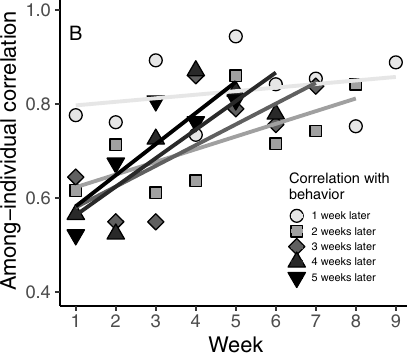
among-individual correlation between behavior in those two weeks; correlations were signi fi cant across all weeks. B Shown are the among-individual correlations between behavior in a given week and behavior 1, 2, 3, 4, or 5 weeks later. The correlations with behavior 2 – 5 weeks later have signi fi cantly steeper slopes than the correlation with behavior 1 week later showing that the among-individual cor- relation in behavior becomes more predictive of laterbehavior,later in life. Notice that the y-axis starts above zero. Source Data are provided as a Source Data fi